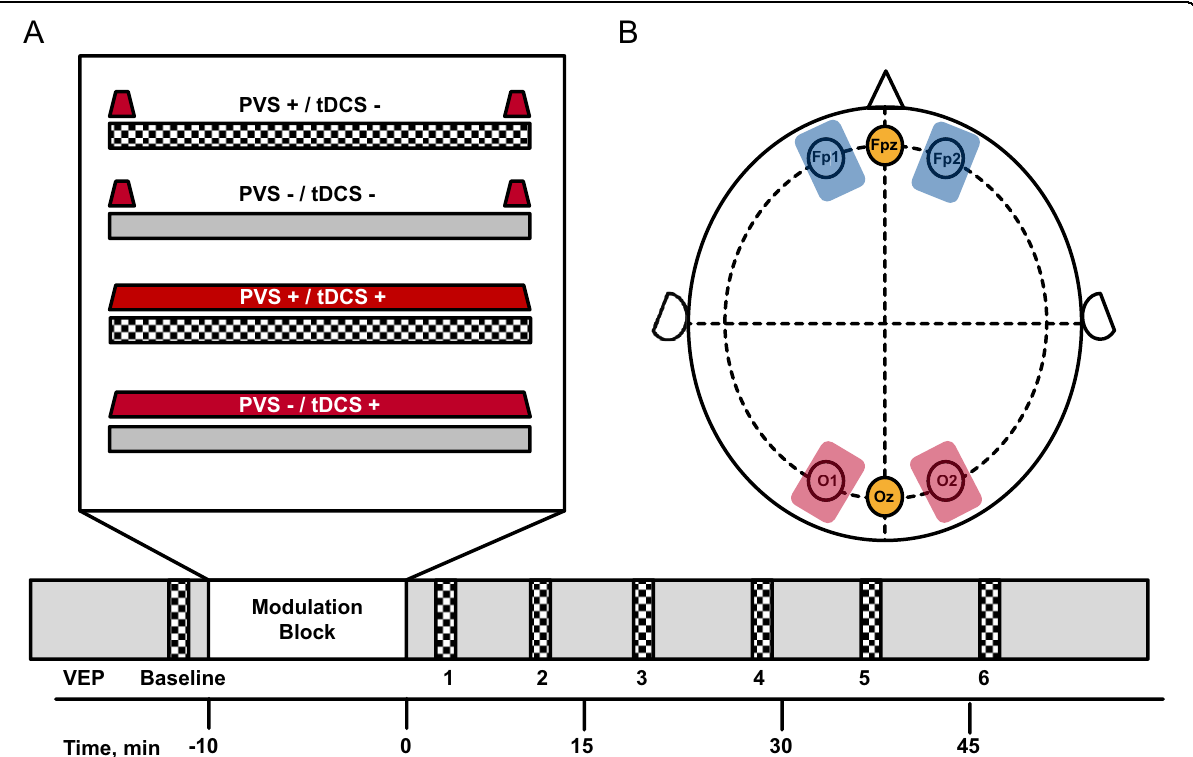
Fig. 1 Study design and electrode placement. A Study design. Four different experimental conditions were used to modulate visually evoked potentials (VEPs), comprising a combination of either verum ( + ) or sham stimulation ( − ) for prolonged visual stimulation (PVS) and transcranial direct current stimulation (tDCS). Every participant performed the experiment over at least two sessions (PVS + /tDCS – and PVS + /tDCS + ). Twenty- fi ve participants underwent an additional test session (PVS − /tDCS + ), and nine participants were randomized into the double sham control condition (PVS − /tDCS − ). Baseline VEP recordings were conducted 2min prior to the stimulation block and experimental VEP recordings 4, 11, 22, 29, 40, and 47min after the stimulation block. B Electrode placement. Bioccipital anodal target electrodes were placed over the occipital cortex (O1 and O2, according to the 10 – 20 electrode positioning system; red), with cathodal return electrodes on the forehead (Fp1 and Fp2; blue). VEPs were recorded from the occipital region on the scalp (Oz; yellow) using a single active gold-cup electrode with a reference electrode placed on the forehead (Fpz;